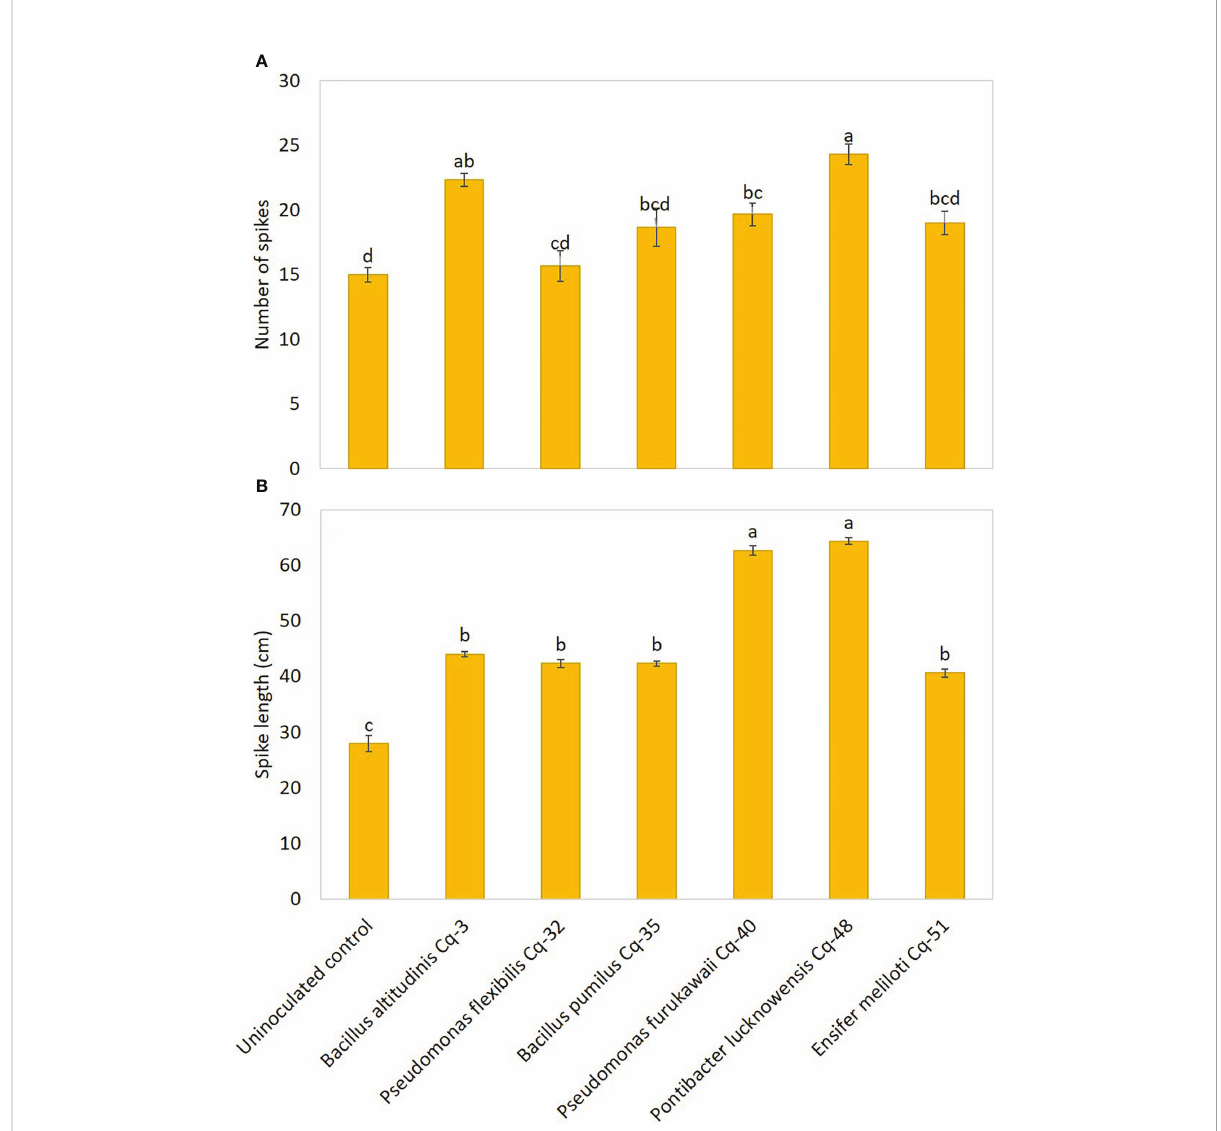
FIGURE 6 Effect of phosphate-solubilizing bacterial strains on quinoa spike count (A) and spike length (B) in fi eld conditions; the control had no inoculum (uninoculated control) and contained only broth; data presented are the mean of three replications along with standard error; the means sharing common letters were considered statistical similar to each other, and least signi fi cant difference (LSD) test was performed at 5% ( P ≤ 0.05) probability